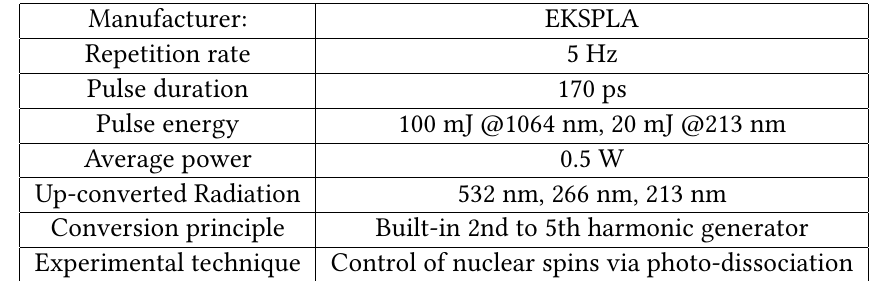
Table 4: Main parameters of Ju